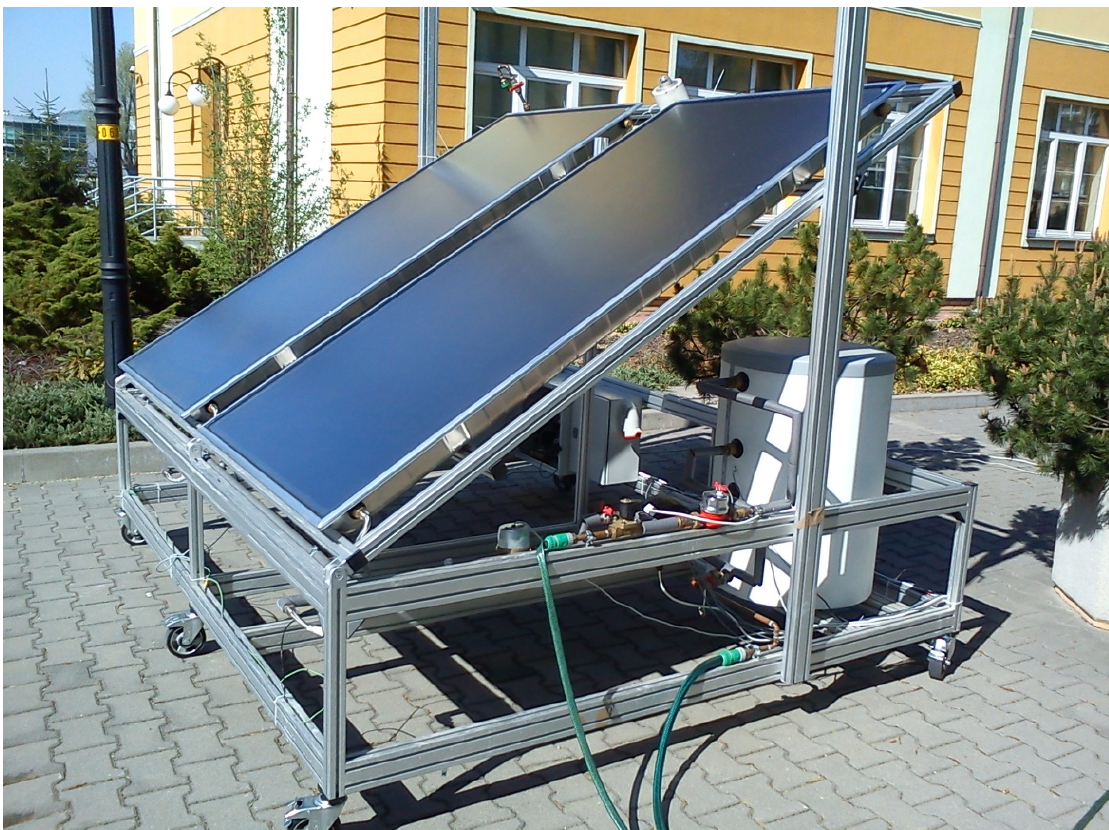
Figure 5. Solar heating